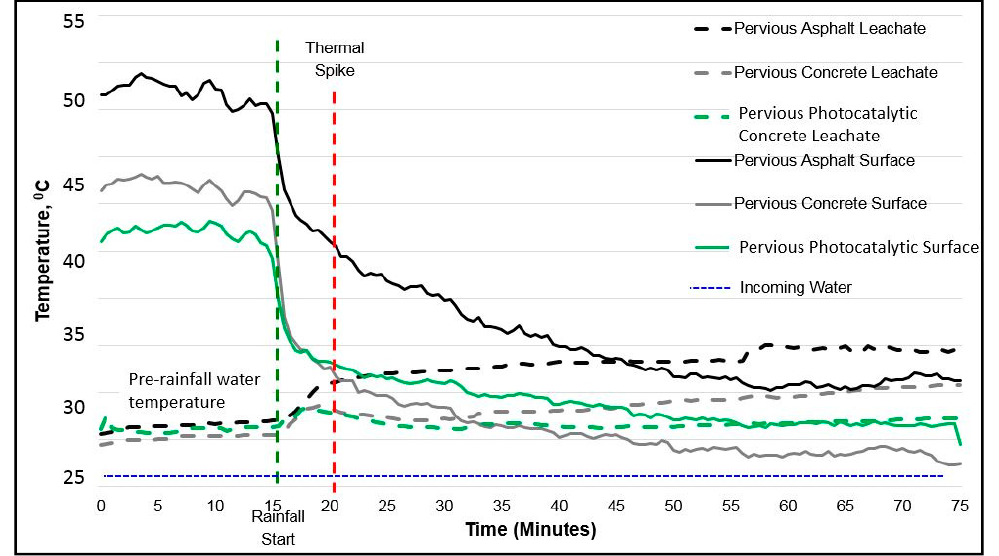
Figure 9. Pervious surface and water temperatures by thermal probe at the outdoor field study site, Auburn University, Auburn, Alabama